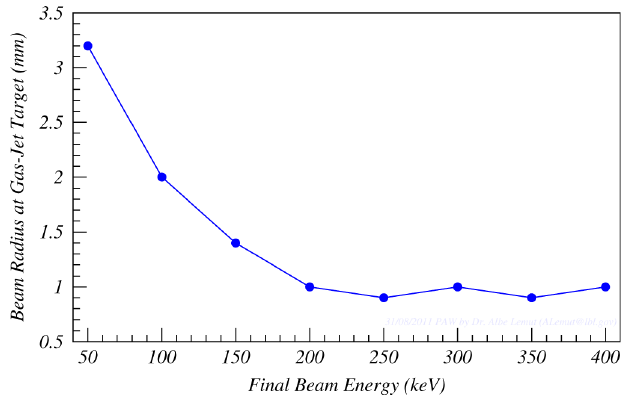
trajectory.FIG. down not to exceed 5 kW of beam power (neutralization 90%).